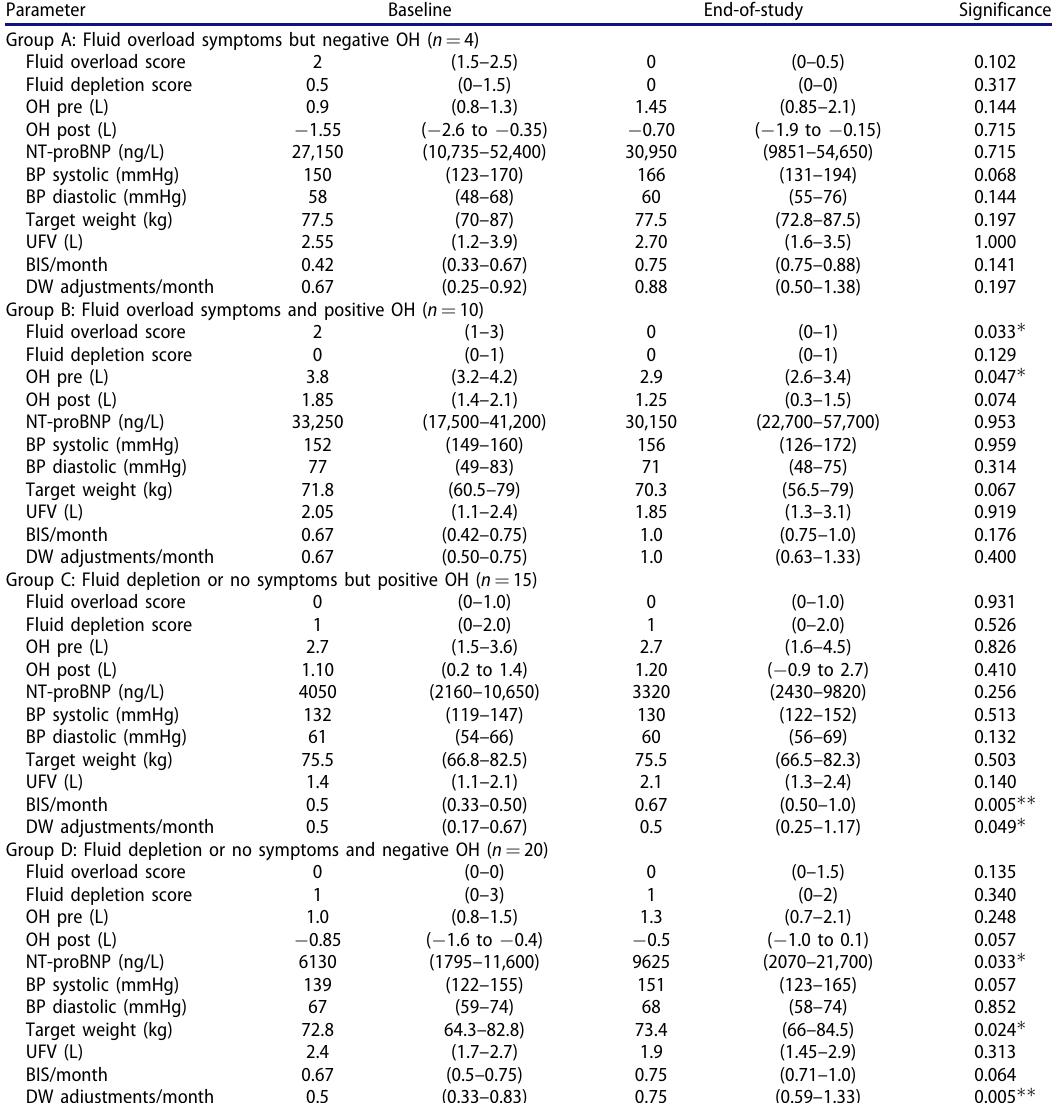
Table 6. Differences between baseline and follow-up observations in subgroups, significance tested with Wilcoxon ’ s non-paramet- ric test between dependent groups. Parameter Baseline End-of-study